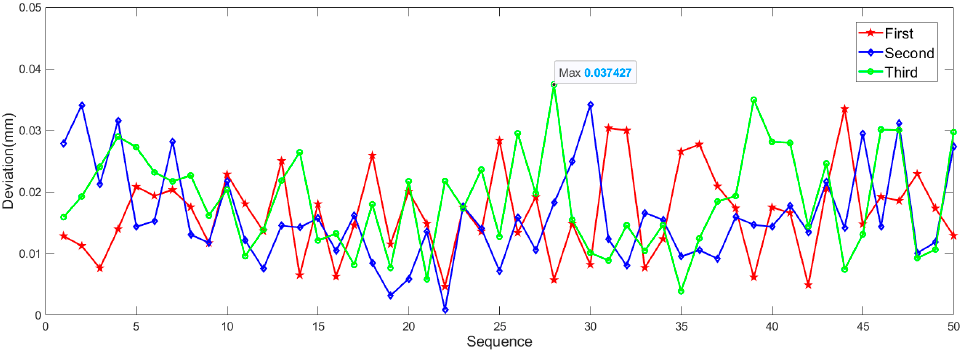
Figure 13. Tracking error under static condition.